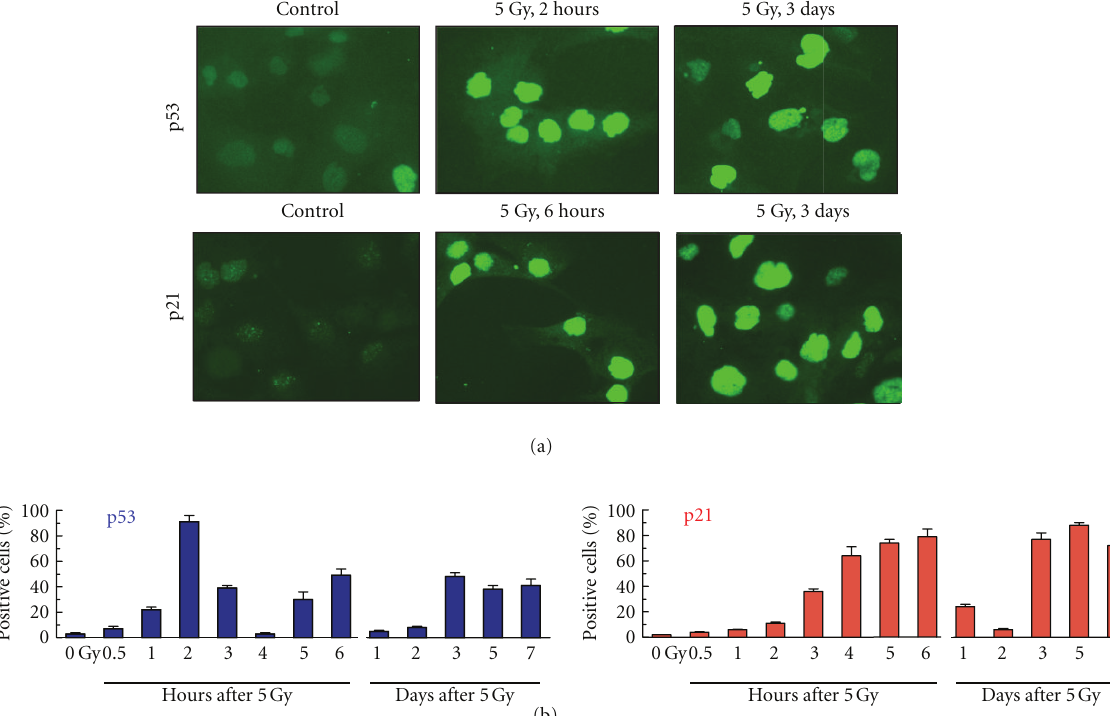
Figure 5: Immunofluorescence analysis of p53 and p21 protein expression in A172 cells after exposure to ionizing radiation (IR; 5Gy). (a) Representative images showing p53 and p21 protein levels in control (non-irradiated) and irradiated cells. [b] Percentages of cells exhibiting nuclear accumulation of p53 or p21 before (control) and at indicated times post-irradiation. Each datum point represents the mean ( ± SD) values of duplicate samples. At least 200 cells were evaluated for each sample. Immunofluorescence analysis of p53 and p21 protein levels was performed using our published techniques